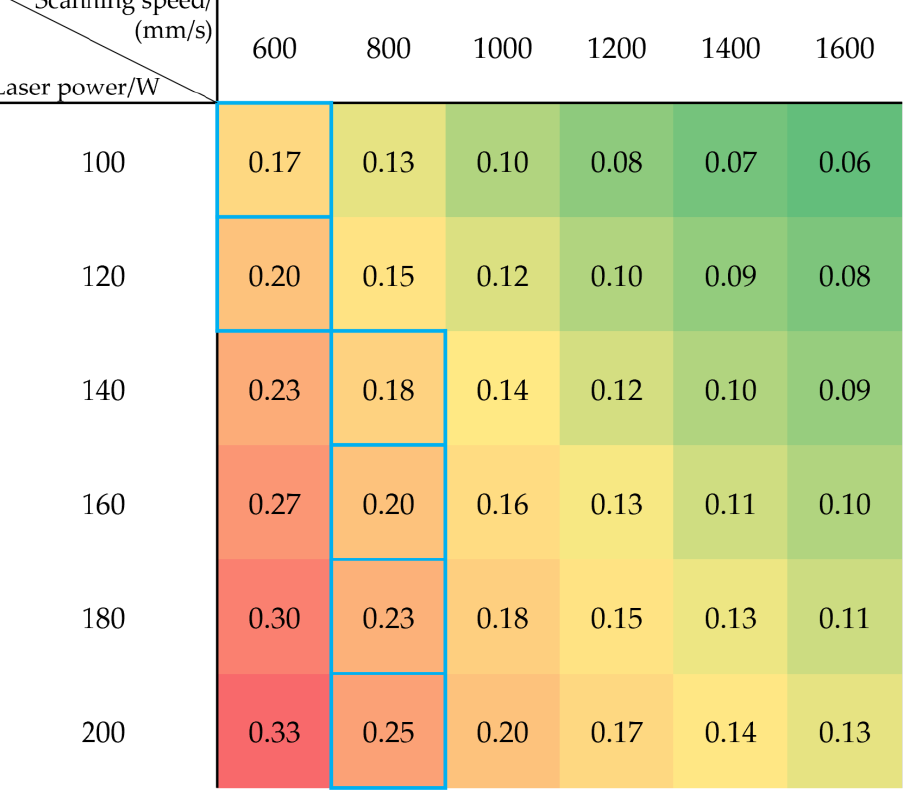
Figure 5. LED during the forming process of each specimen(J/mm). The main factors affecting the USR include spatter behavior, outer edge bulges, and bulges and depressions caused by spheroidization. Spatter is an unavoidable phenomenon in the SLM forming process, including the powder spatter formed by the metal powder escaping the powder bed under the action of gas entrainment and the droplet spatter formed by the escaped molten pool melt or the powder spatter undergoing sputtering and condensation under thermal radiation [18]. On the regular and continuous upper surface of the melting channel, the spatter behavior is the main factor affecting its surface roughness. The outer edge bulge is caused by too short laser on delay or too long laser off delay, which causes the laser to irradiate the powder bed for too long, the energy absorption at the end of the scanning line is too large, and the molten pool increases. At the same time, the end of the scanning line is more exposed to metal powder than other places, and the inhalation of the metal powder by the molten pool further increases the melting width and melting height at the endpoint of the scanning line, thereby forming an outer edge bulge. Cooperative control of laser delay and scanner delays to make them suitable for well-defined jump speed and mark speed can effectively solve the problem of outer edge bulge [19]. Laser energy density is an important factor affecting the spheroidization phenomenon, so choosing an appropriate linear energy density is the key to ensuring the quality of the upper